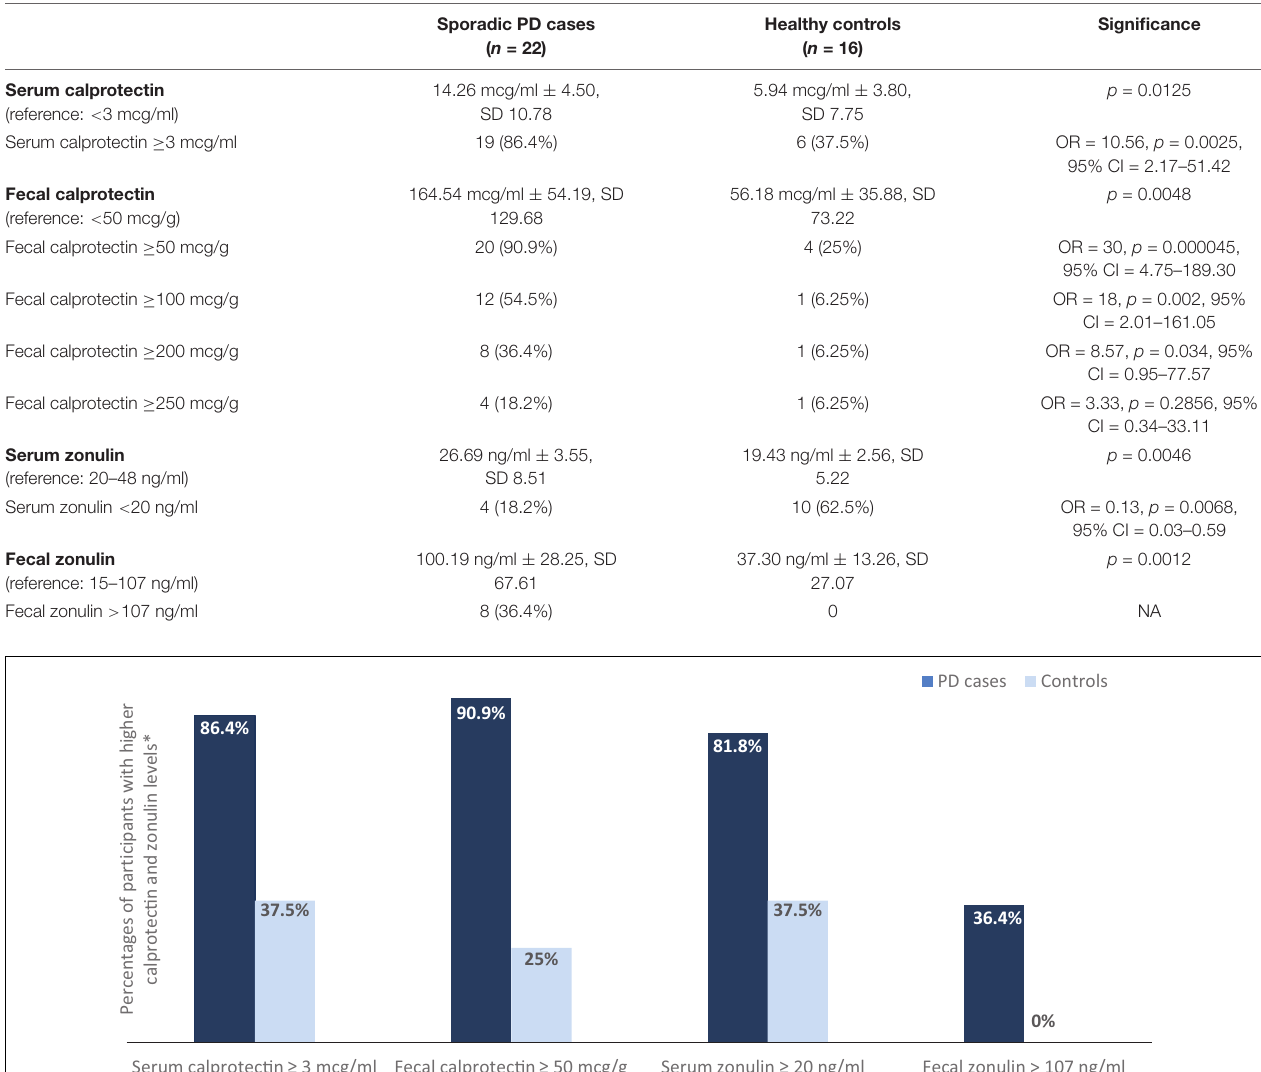
TABLE 2 | Calprotectin and zonulin levels.